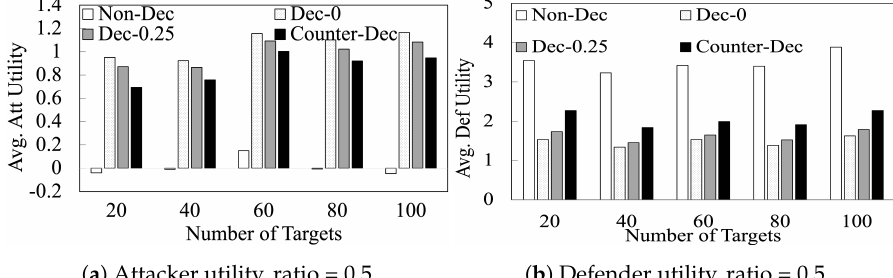
Figure 6. Player Utilities with Varying Number of